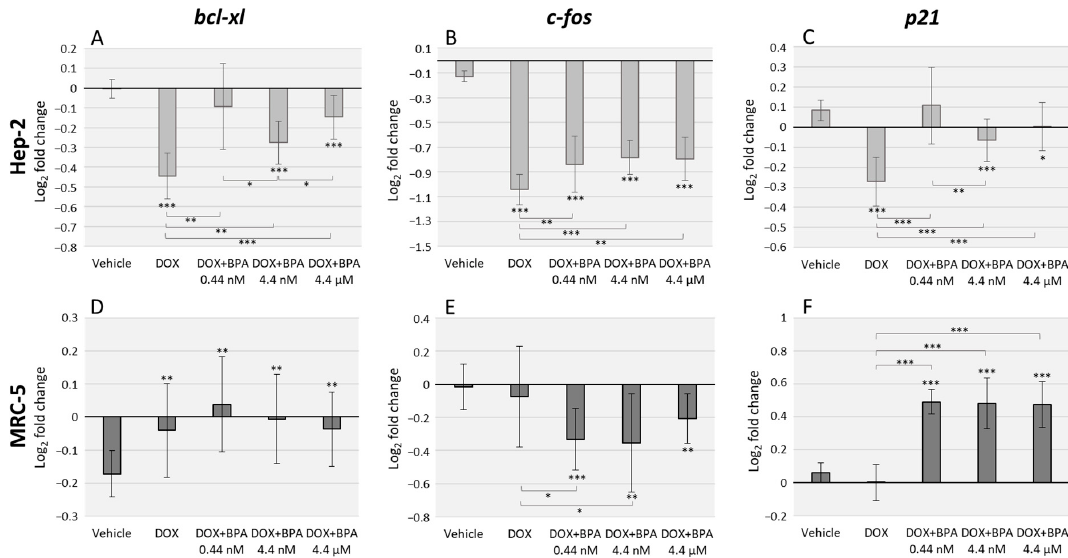
Figure 2. qRT-PCR analysis in Hep-2 ( A – C ) and MRC-5 ( D – F ) cell lines after exposure to doxorubicin (DOX) alone and in combination with three different environmentally relevant concentrations of BPA namely 0.44 nM, 4.4 nM, and 4.4 µ M. Data represent the relative expression for the genes: bcl-xl ( A , D ), c-fos ( B , E ) and p21 ( C , F ). GAPDH and β -actin were used for normalization. Error bars represent the standard deviation between two independent treatments and three qRT-PCR replicates. Significant statistical values, which were compared with the vehicle (EtOH) and calculated with Student’s t -test, are illustrated as: * p < 0.05, ** p < 0.01 and *** p < 0.001.